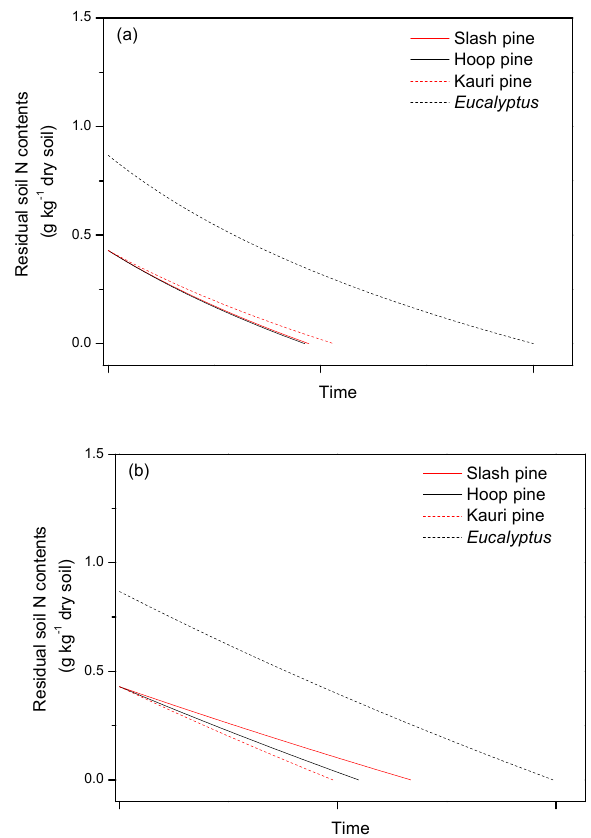
Figure 5. Residual soil N contents under different tree species with N -acetylglucosaminidase (a) and leucine aminopeptidase (b) across time. The total soil N decomposition over time was calcu- lated via Eq. (6) and the residual soil N contents over time was compared for different enzyme activities among the tree